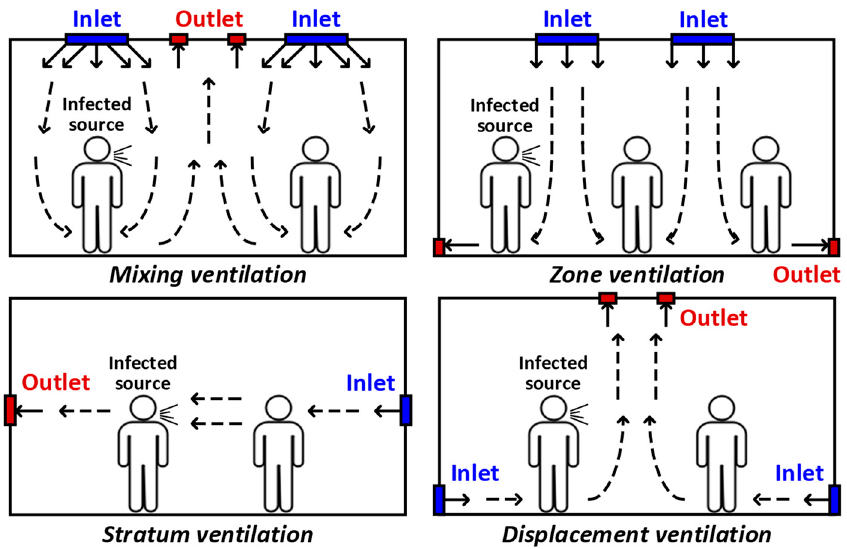
Figure 1. Sketch map of different ventilation modes.